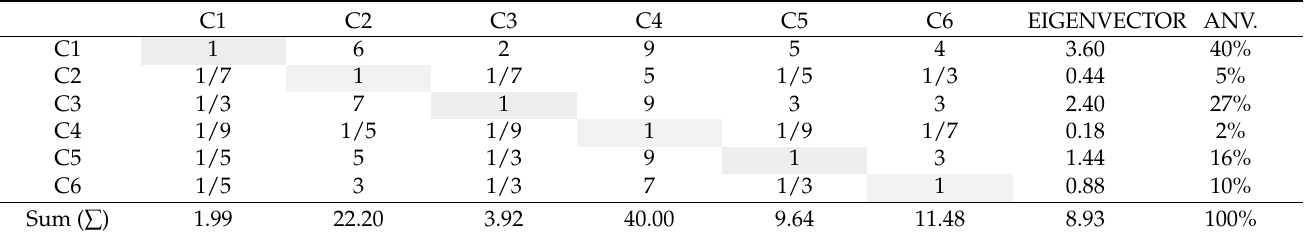
Table 5. Pairwise comparison matrix between the indicators of the Jequitinhonha River Hydrographic Basin.